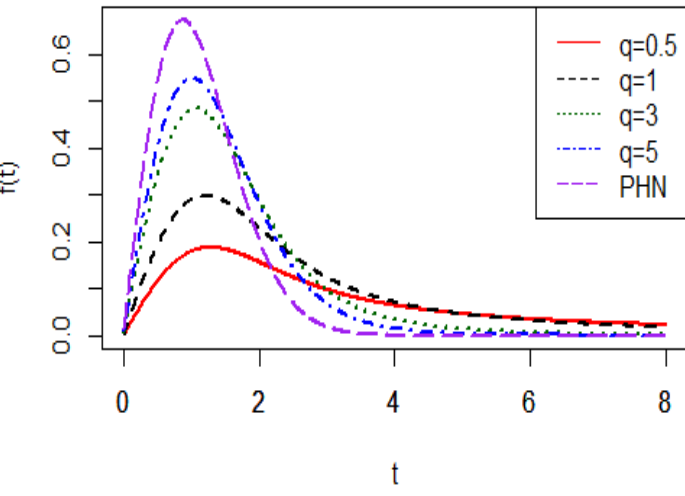
Figure 1. Plots of the SPHN(1,2, q ) model.